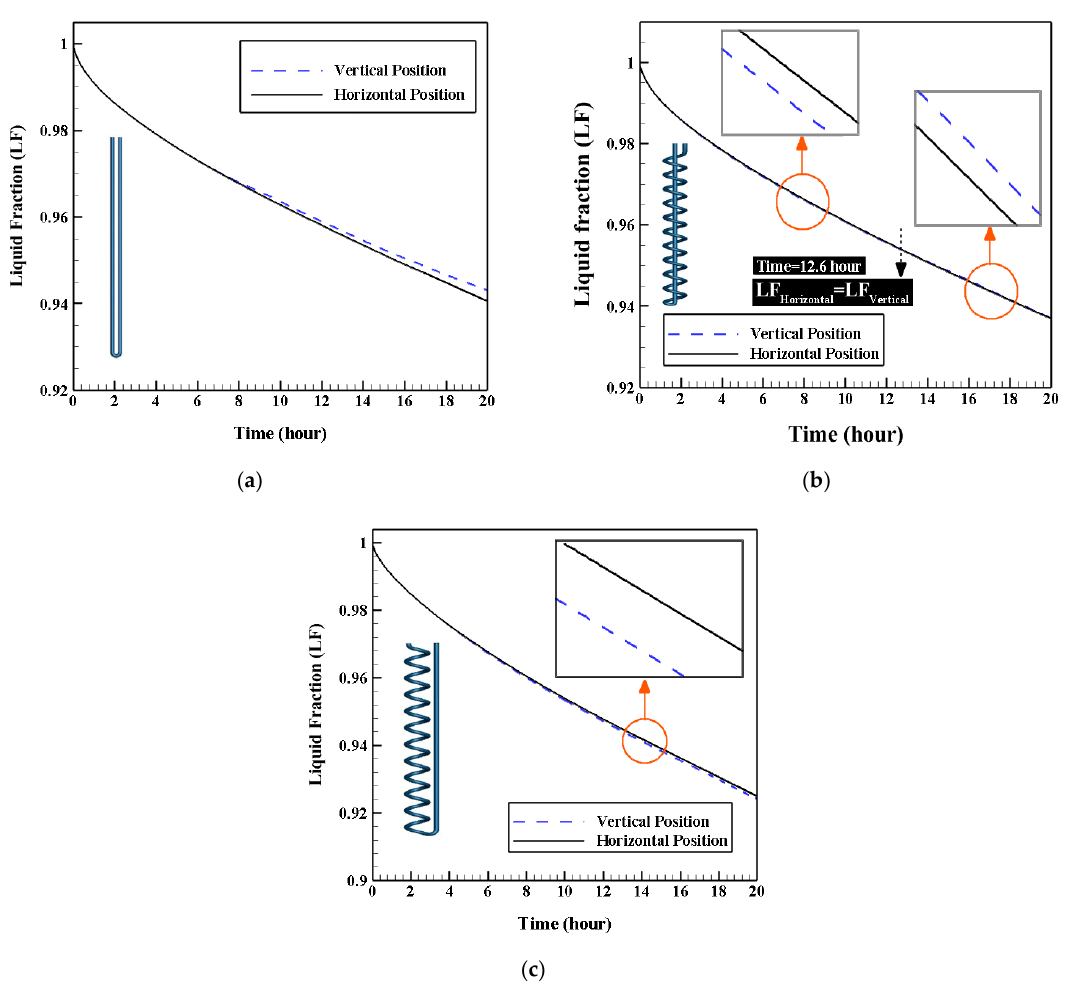
Figure 13. Comparison between two positions of the ice-on-coil ice storage system: ( a ) single U-shaped, ( b ) coil tube-model 1, ( c ) coil tube-model 2.